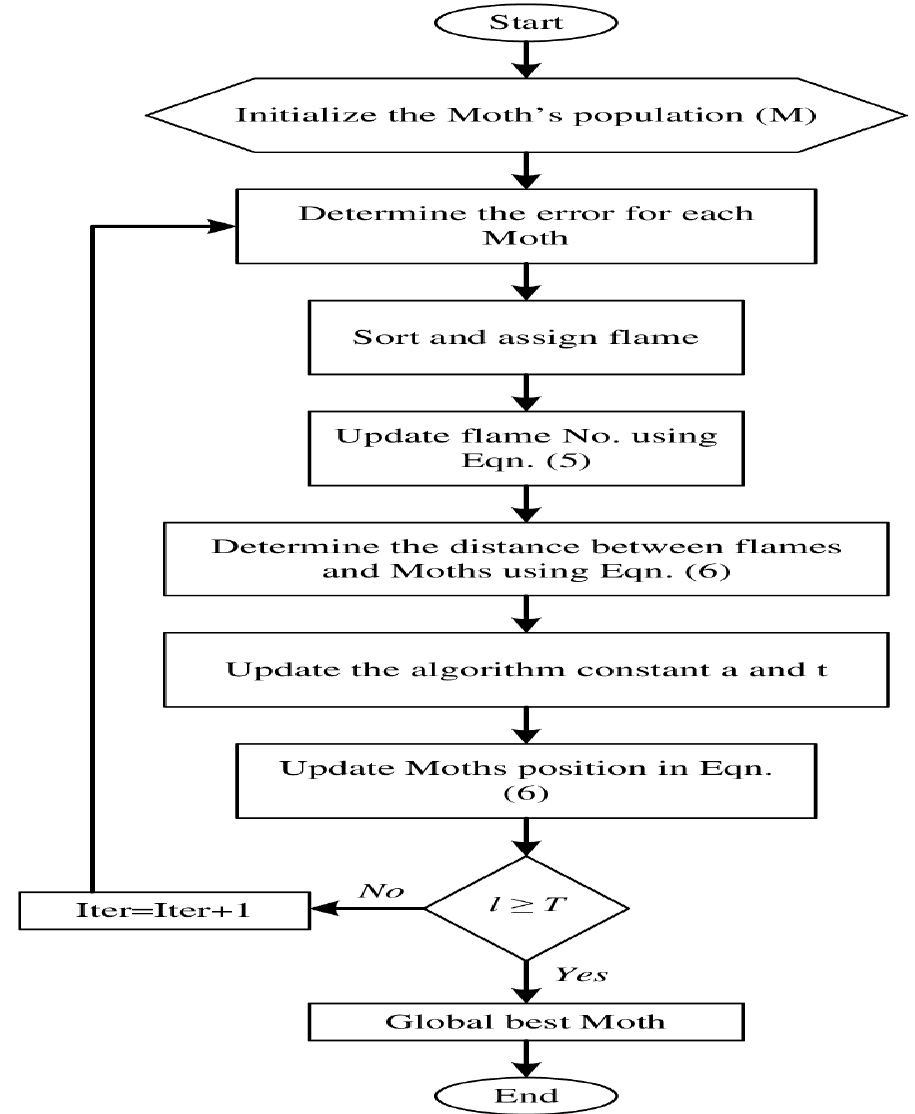
Figure 3. Moth-flame optimization algorithm flowchart. Figure 3. Moth‑flame optimization algorithm flowchart. Assume that the matrices M = ( N , dim ) and F = ( N , dim ) are used to represent the set of moth and flame, and that flames and moths are potential solutions to issues. In the formula, N represents the maximum number of flames and dim represents the population of moths. The flames reflect the best location obtained from the moths, and the moths represent the real search topics travelling through the scope of the search. According to the greedy retention principle, which stipulates that the flame structure preserves the best N solutions to the moth’s flight history, the position of the moth and the flame structure are updated with the moth’s spiral flight [41]. The spiral flying mechanism has the following